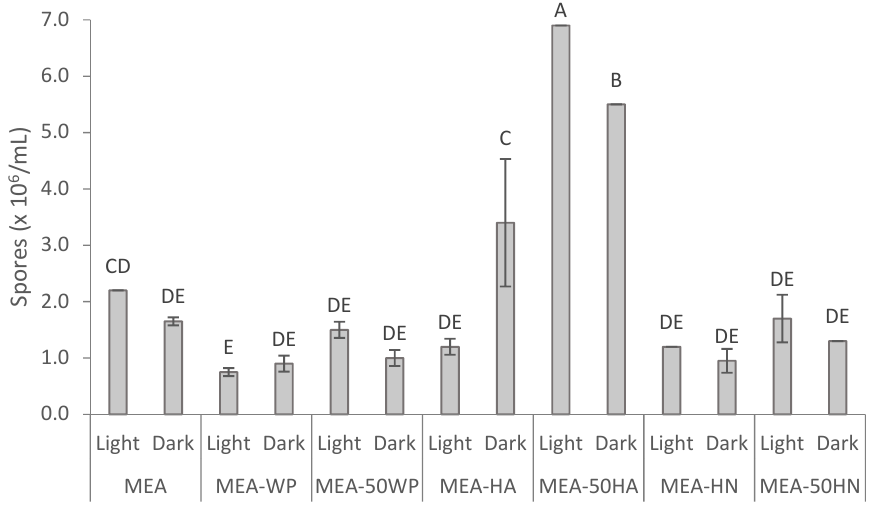
Figure 5. Effect of medium composition and presence or absence of visible light on sporulation of F. striatum . MEA: malt extract agar medium; MEA-WP: malt extract agar medium without peptone; MEA-50WP: malt extract agar medium without peptone and 50% of malt extract; MEA-HA: malt extract agar medium containing Alcalase 2.4 L hydrolysate; MEA-50HA: malt extract agar medium with 50% of malt extract replaced by Alcalase 2.4 L hydrolysate; MEA-HN: malt extract agar medium containing Neutrase 0.8 L hydrolysate; and MEA-50HN: malt extract agar medium with 50% of malt extract replaced by Neutrase 0.8 L hydrolysate. Different letters indicate significant differences among culture media ( p <